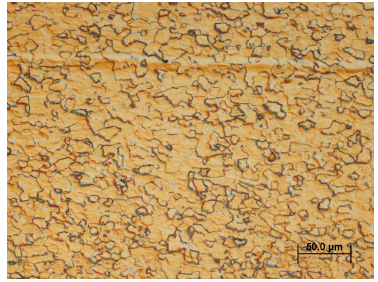
Table 8. Sheets-surface parameters acc. to ISO 4287, Profilomer SJ-201 ( μ m) .